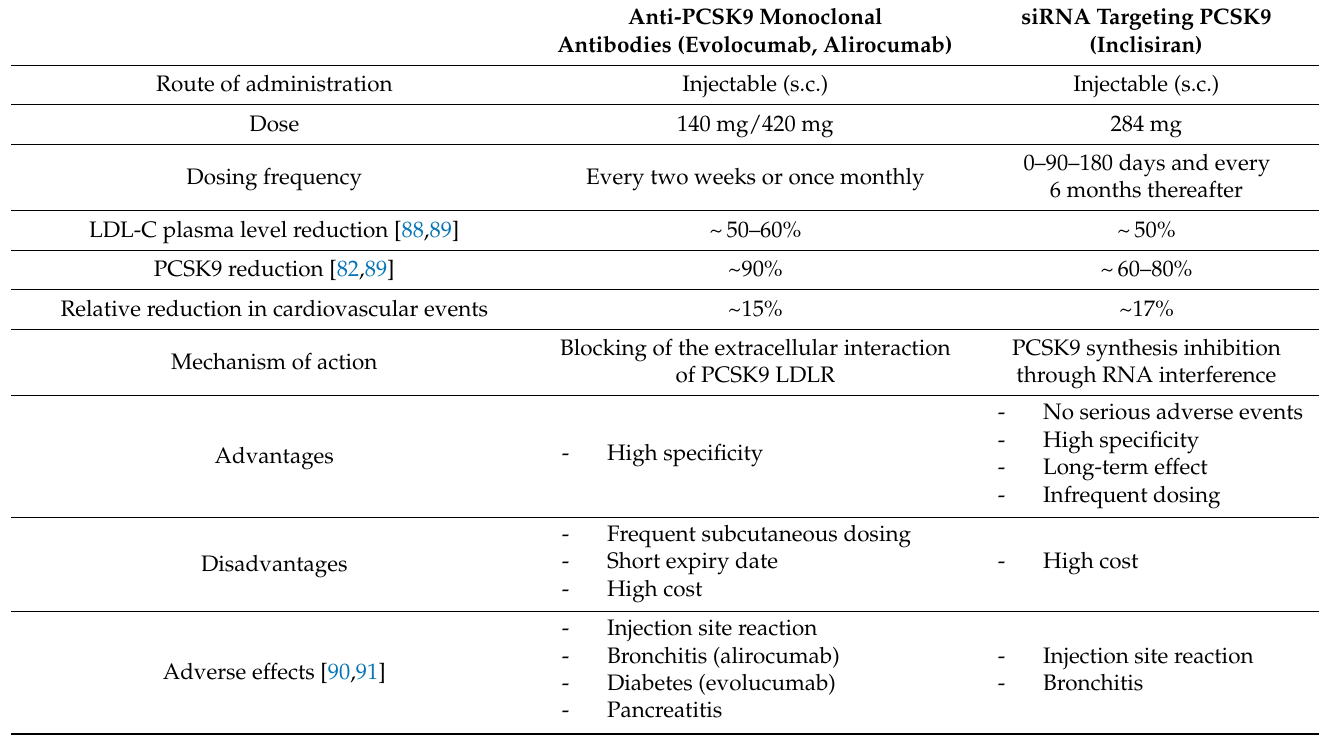
siRNA Targeting PCSK9 (Inclisiran)